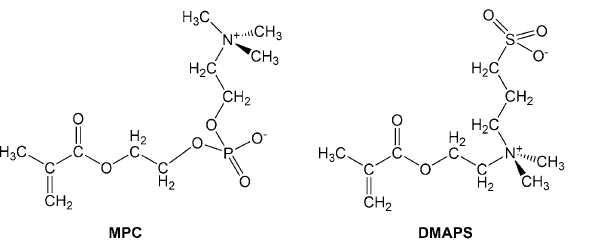
Figure 1. Molecular structures of 2-methacryloyloxyethyl phosphorylcholine (MPC) and 3-[dimethyl-(2- methacryloyloxyethyl) ammonium] propane sulfonate (DMAPS).